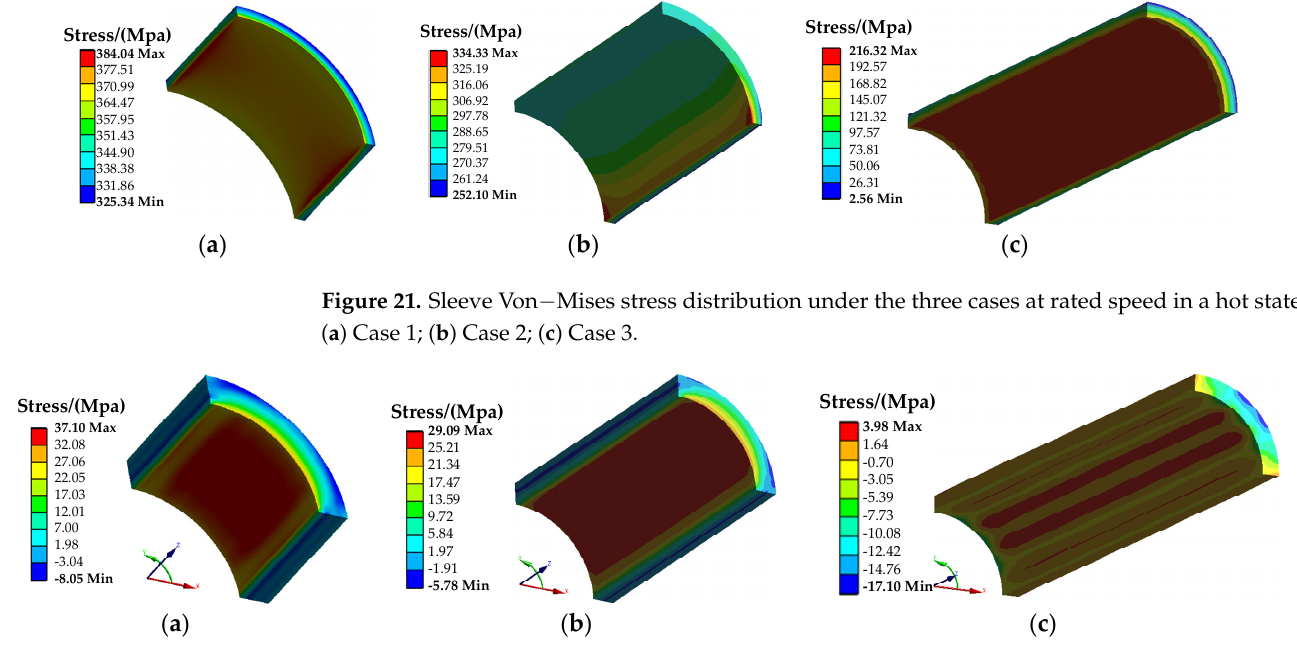
( c ) Figure 23. Permanent magnets’ radial stress distribution under the three cases at rated speed at a hot state: ( a ) Case 1; ( b ) Case 2; ( c ) Case 3. From the above rotor stresses analysis under the cold and hot state, it can be found that as the rotor length ‐ diameter ratio increases, the rotor outer diameter gradually de ‐ creases, thus the rotor stress gradually decreases, indicating that the mechanical reliability of the rotor gradually increases. 4.4. Rotor Dynamics Characteristics Analysis When the high rotor speed of HSPMMs reaches its critical speed, the rotor would resonate and damage the rotor. To avoid resonance, the rated speed of the rotor should be less than 0.7 times the first ‐ order critical speed. The first ‐ order critical speed of the rotor is related to the diameter and length of the rotor. For case 1,